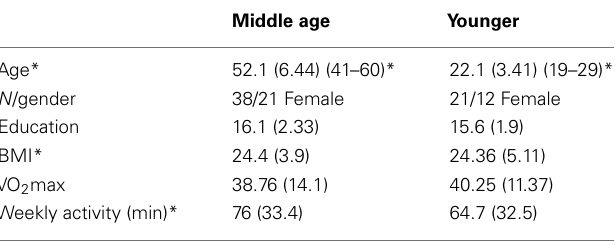
BMI, body mass index. Cell values denote group means. Parentheses indicate standard deviation within cell. Bracket indicates range. Student’s t-test contrast significance at *p <